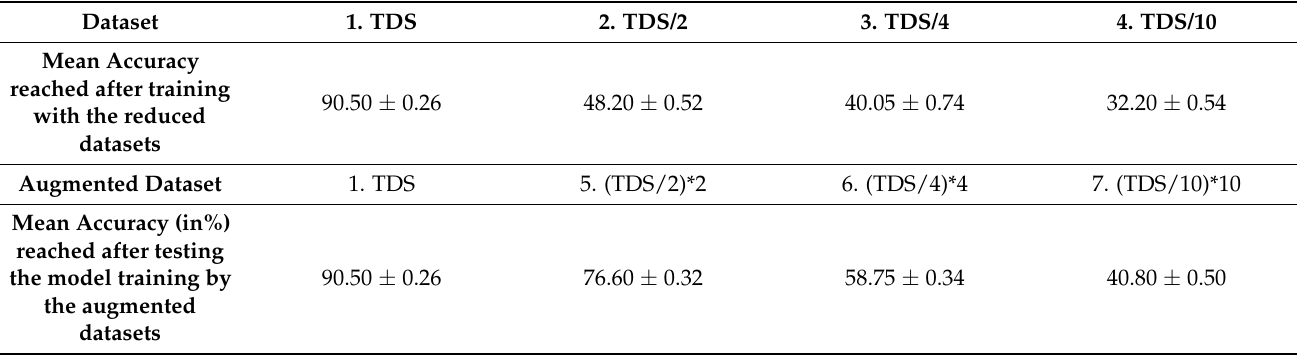
Table 8. Experiment-3: Performance comparison; TDS is the original dataset where 100 graphs are for training and 50 graphs for testing. The Numerical Augmentation ratio is Dataset ×